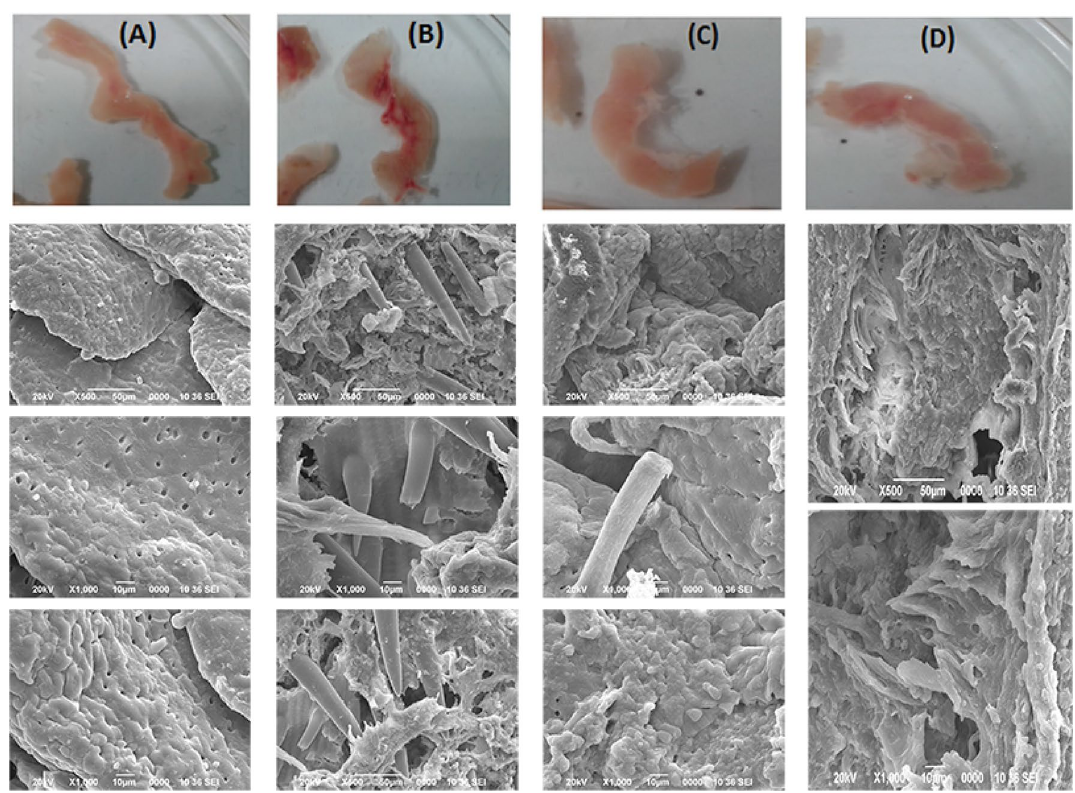
Figure 8. Excised intestines and SEM images of the intestinal section from ( A ) RG-CF (colitis free control group without any treatment) rats, ( B ) RG-CI (colitis induced group without any treatment) rats, ( C ) RG-SP (colitis induced group treated with SAPE) rats, RG-IM (colitis induced group treated with indomethacin)